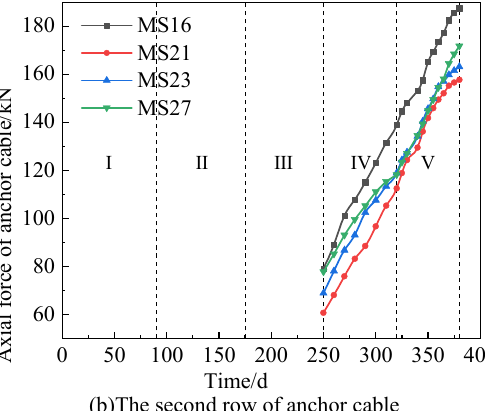
Figure 12. Variation curve of the axial force of the brace.